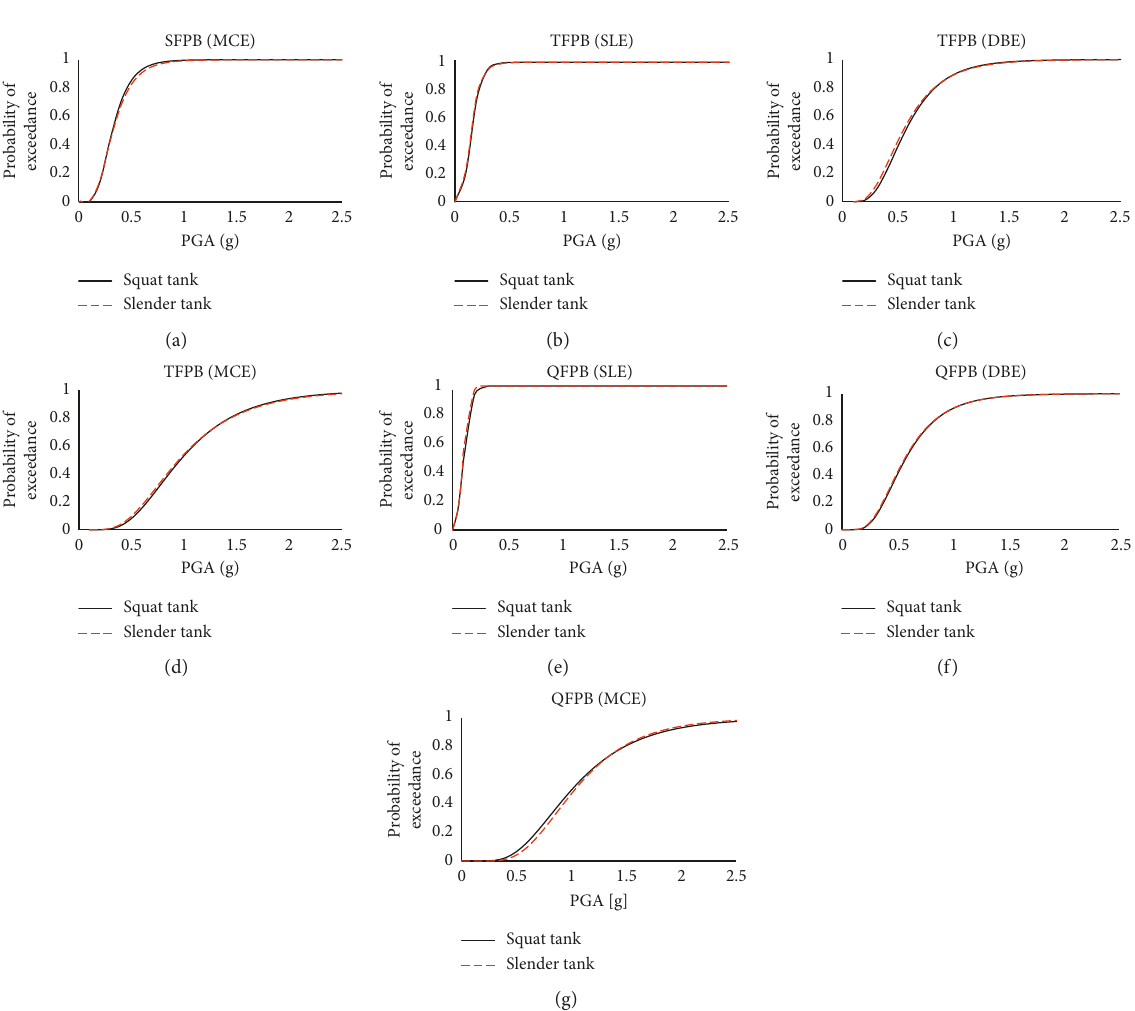
Figure 10: PBD fragility curves of squat and slender tanks using SFPBs, TFPBs, and QFPBs